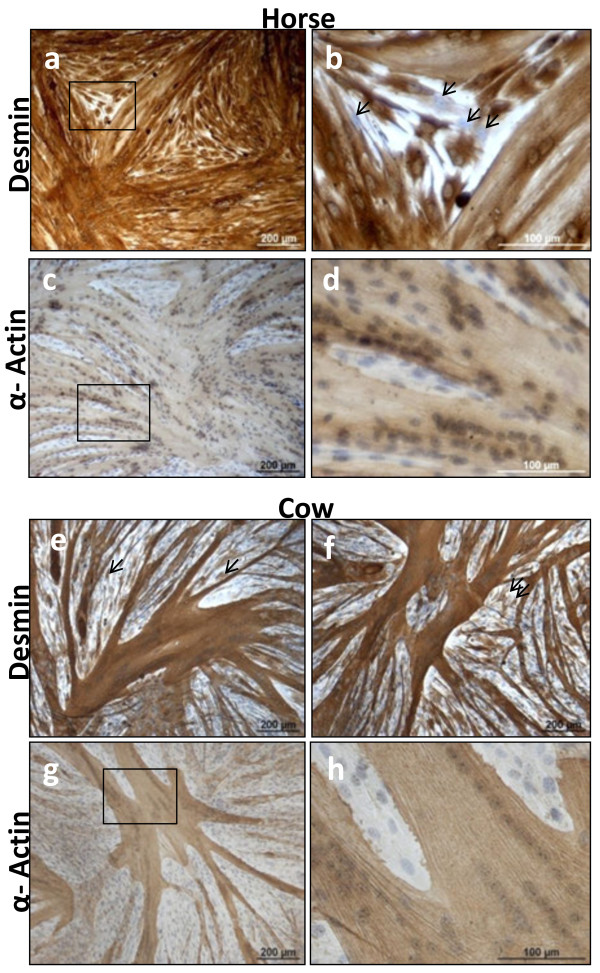
Extensive differentiation and fusion of primary equine and bovine muscle immunolabeled for the muscle markers desmin and α-sarcomeric actin. Equine muscle cells isolated from the red (oxidative) biceps femoris fused as readily as duck muscle cells (a-d). At day 4 of culture, equine cells appeared to express the highest level of desmin in relation to all the species examined (a, b). With over 95% of cells positive for desmin, the equine muscle culture ostensibly contained very few non-muscle cells (b, arrows). α-Sarcomeric actin immunolabeling (brown staining) was detected in equine myotubes but not in mononucleated cells (c, d). Bovine myogenic cells from psoas major (oxidative muscle type) also showed extensive cell fusion after 3 days of culture (e-h). Desmin expression was present in all myotubes (e, f) but also in some myoblasts (e arrows, f arrows). α-Sarcomeric actin was detected in bovine myotubes only (g, h). Haematoxylin nuclear counterstain was used.